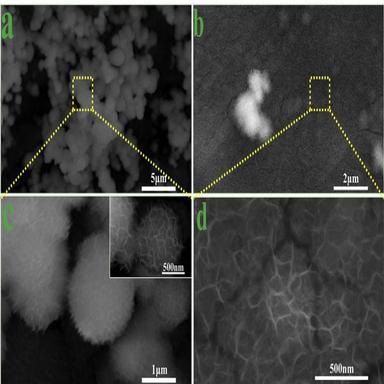
SEM images of NiMoO4 nanoarrays (NM-6).